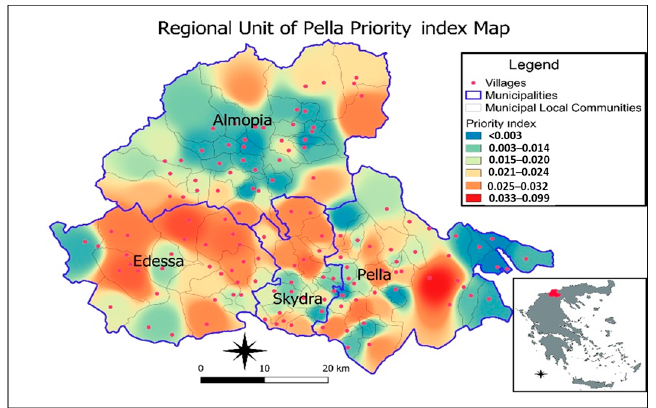
Figure 3. Relative Priority Map (RPIA) for year 2018.